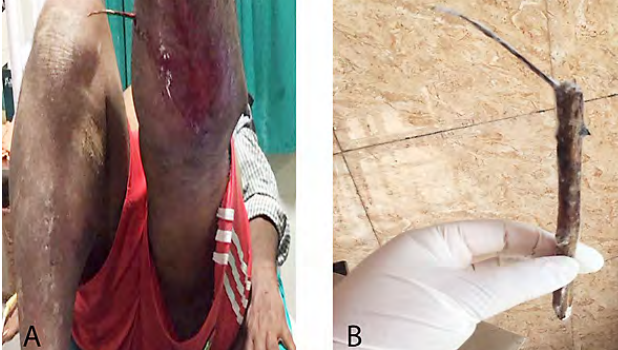
Fig 2 : A 54 old male with penetrating injury by wooden foreign body in left calf; B Removed wooden foreign body.